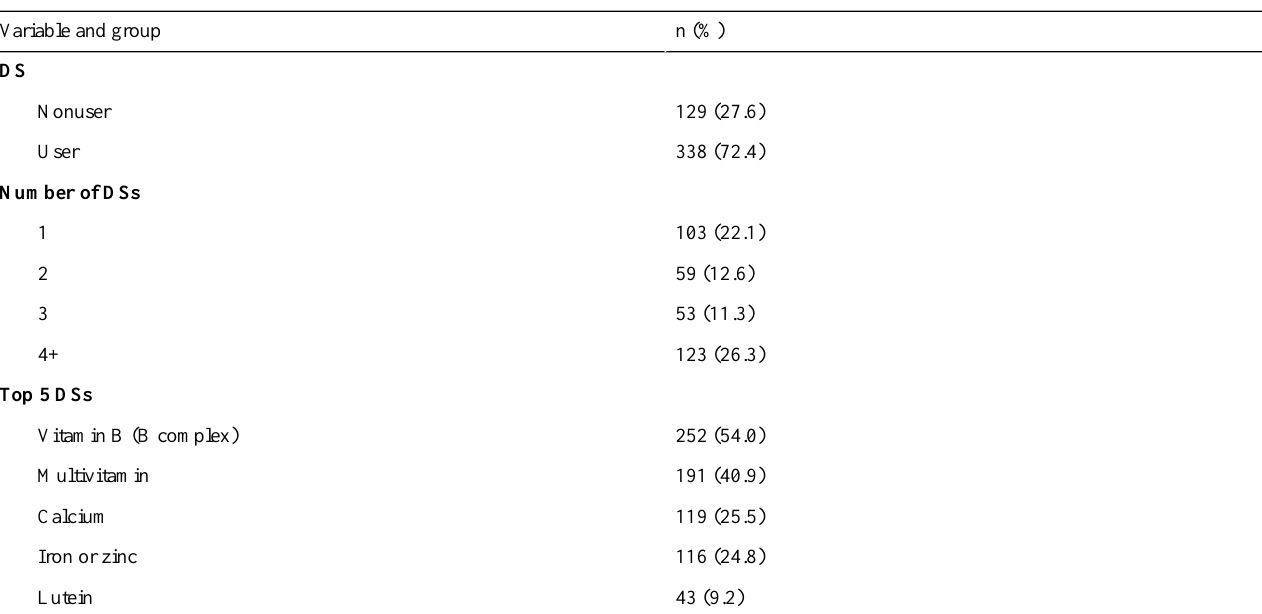
Table 3. Participants’reported use of DSs (N=467) a